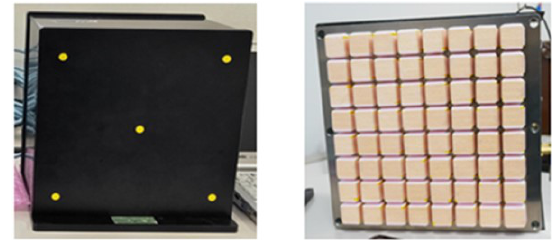
Fig. 3. Fast neutron pixel-type